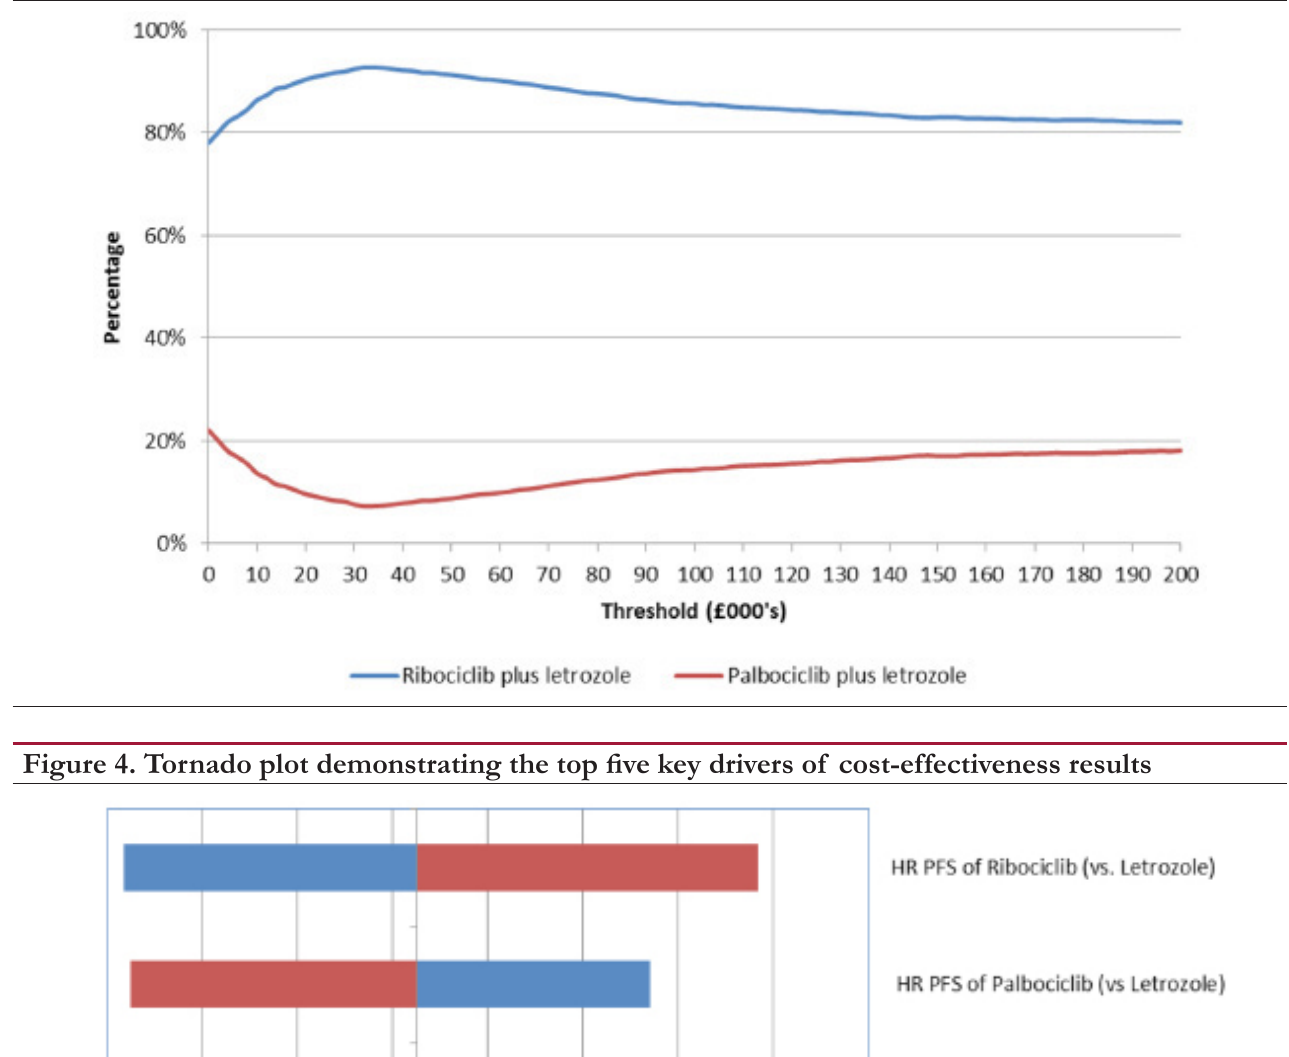
Figure 3. Cost-efficiency acceptability curve